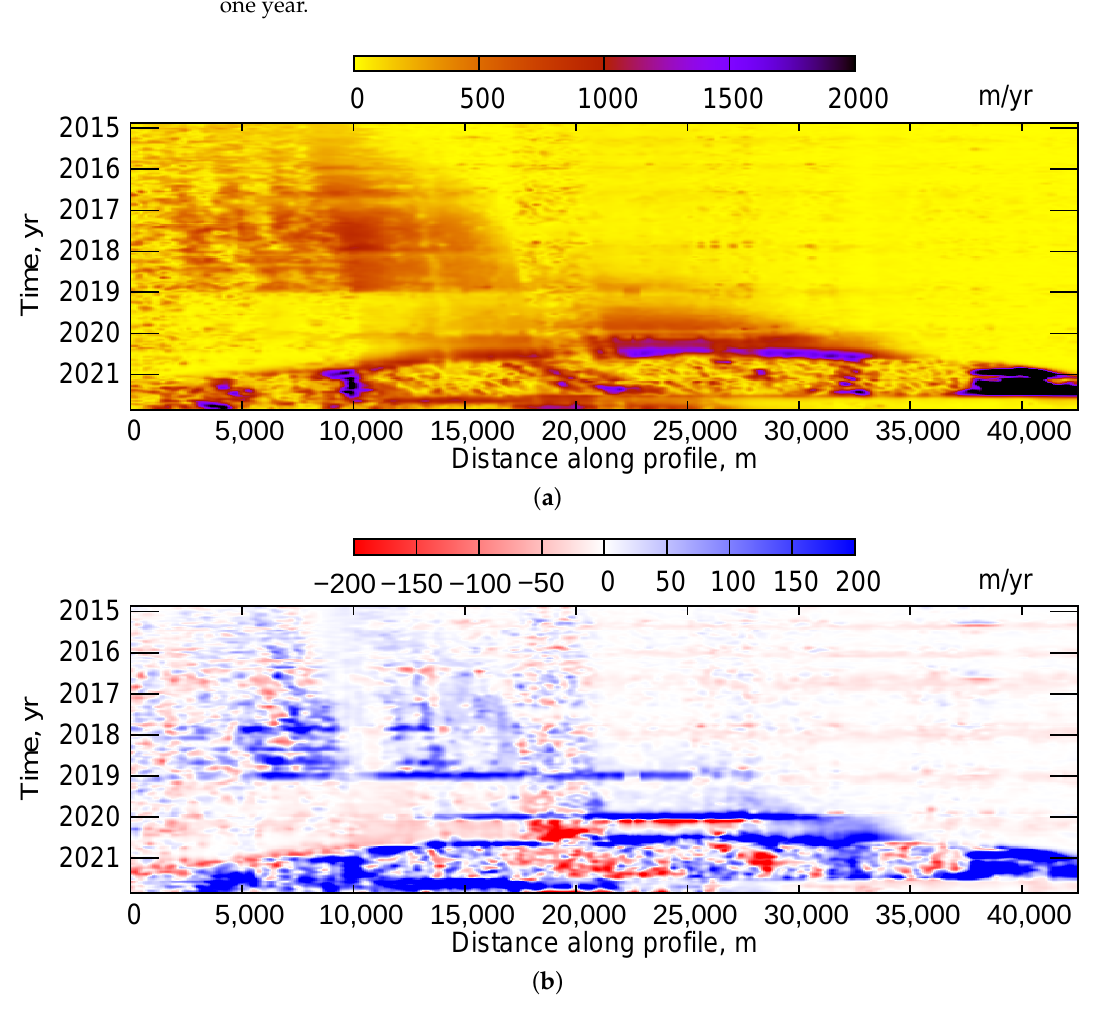
Figure 6. Temporal evolution of ( a ) magnitude of horizontal flow velocity and ( b ) vertical nSPF flow velocity during